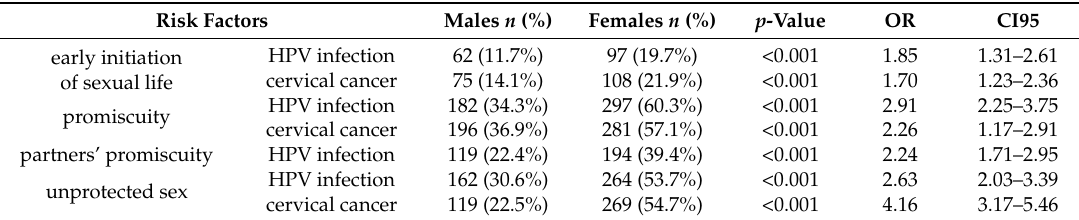
Table 7. Gender-based comparison of knowledge about common risk factors for HPV infection and cervical cancer.